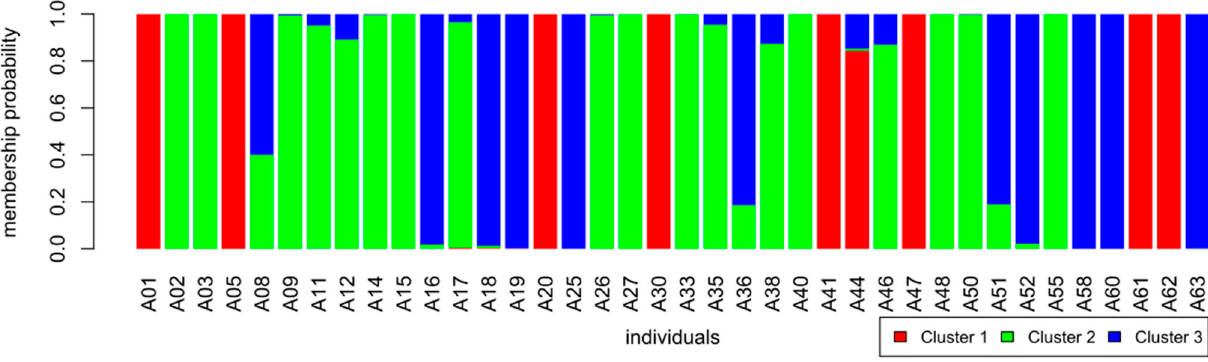
Figure 2. Scatter plot of discriminant analysis of principal components (DAPC) for SSR-data, three PCs and three DAs retained. Color code and group-ellipses according to the three calculated clusters. The box on the upper left shows the retained DA eigenvalues, while the box on the upper right shows that three PCA eigenvalues have been retained.